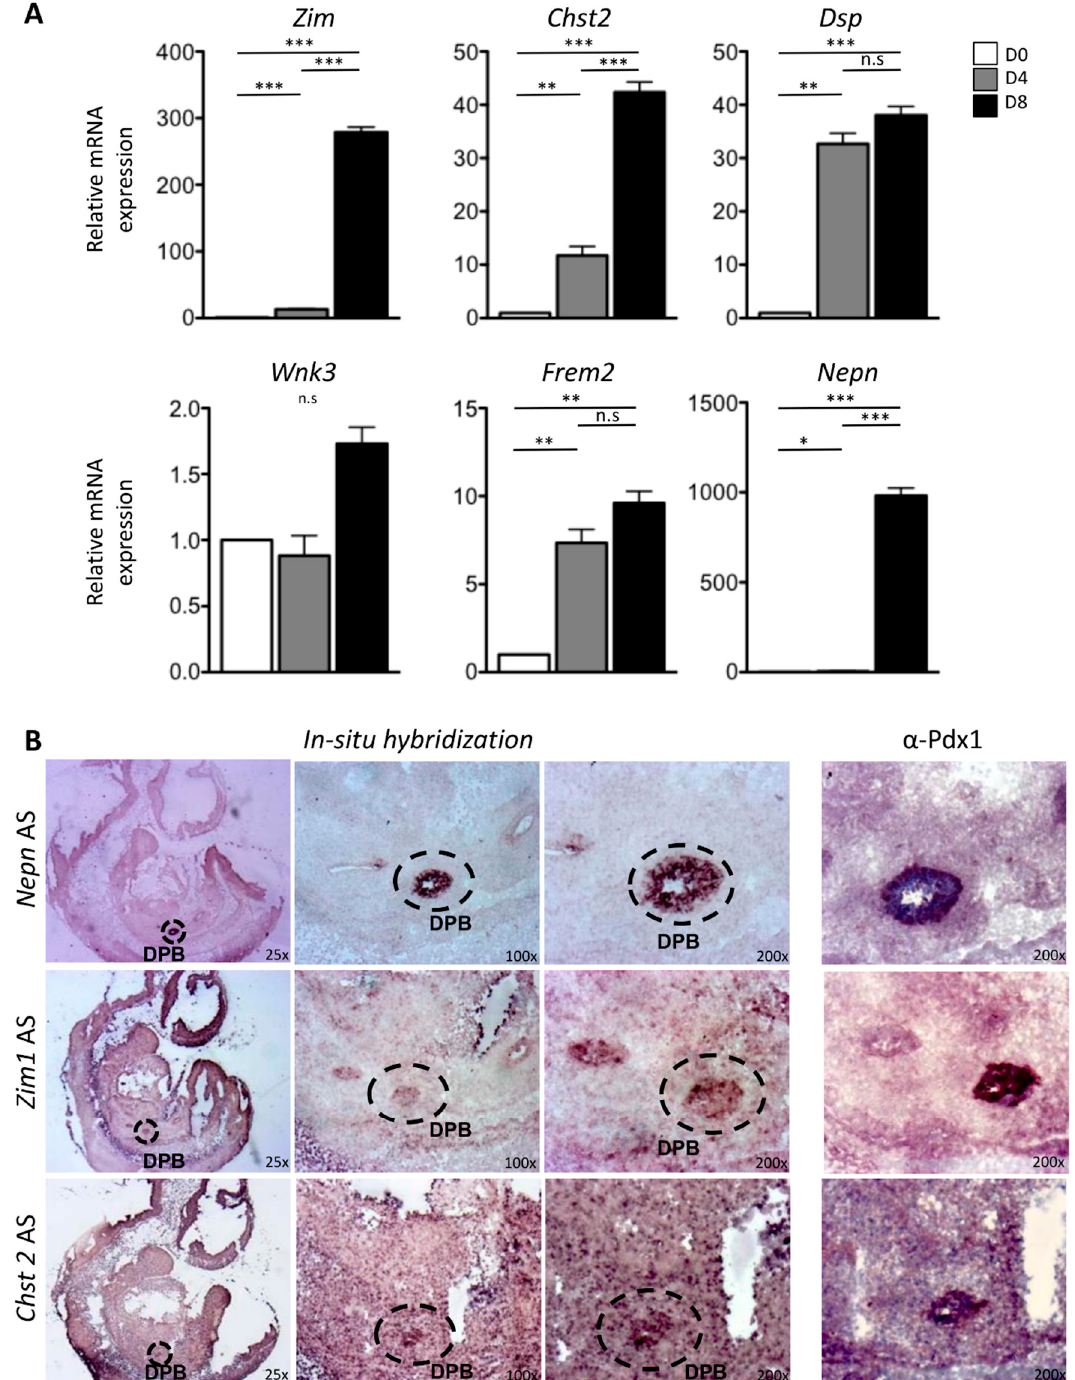
Figure 3. ( A ) qPCR of the selected enriched genes of DPB (Frem2, Chst2, Zim1, Dsp, and Wnk3) during mESCs di ff erentiation. mESCs were plated at day 0 in a prodi ff erentiative medium supplemented with Matrigel and Activin A to induce the DE formation (D4). The cells were then treated with retinoic acid and FGF10 until the end of protocol to promote the Posterior Foregut Endoderm (PFE) formation. Total RNA was extracted at D0, D4, and D8 to perform qPCR. White, gray, and black histograms represent D0, D4, and D8, respectively. Nepn expression is used as bona fide marker for pancreatic di ff erentiation. Gapdh expression level is used as reference gene. The data reported are normalized on Gapdh expression. Statistical analyses were performed using Student’s t -test, with p < 0.05 considered significant. (* p < 0.05, ** p < 0.01, *** p < 0.001, n.s p > 0.05). Values are shown as means of three independent RT-qPCR experiments ± SD in triplicates. ( B ) In situ hybridization of the selected DPB gene on mouse embryos at E10.5. In situ hybridization was